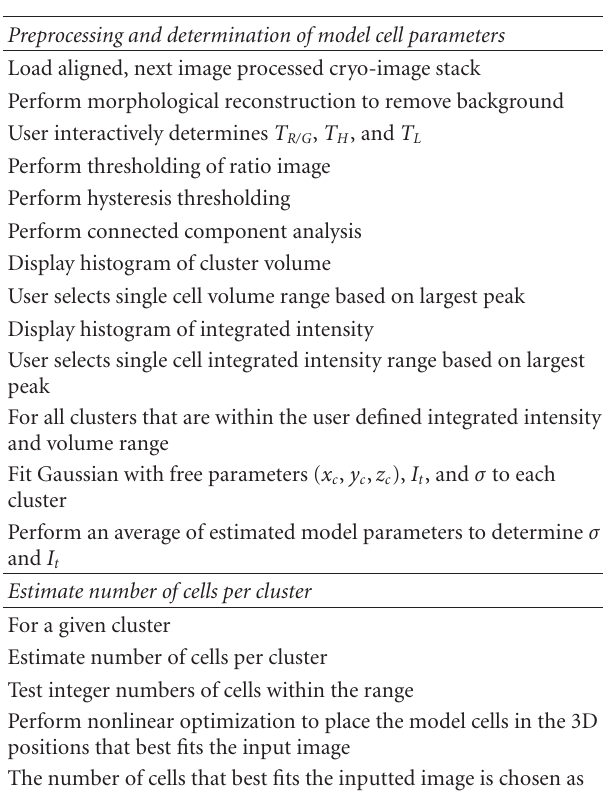
Table 1: Pseudocode for the determination of model-based parameters and estimation of cell number. Histogram analysis of cluster volume and integrated intensity are used to estimate single cell clusters. Model parameters are determined from the estimated single cells. These parameters are used to estimate the number of cells in a given